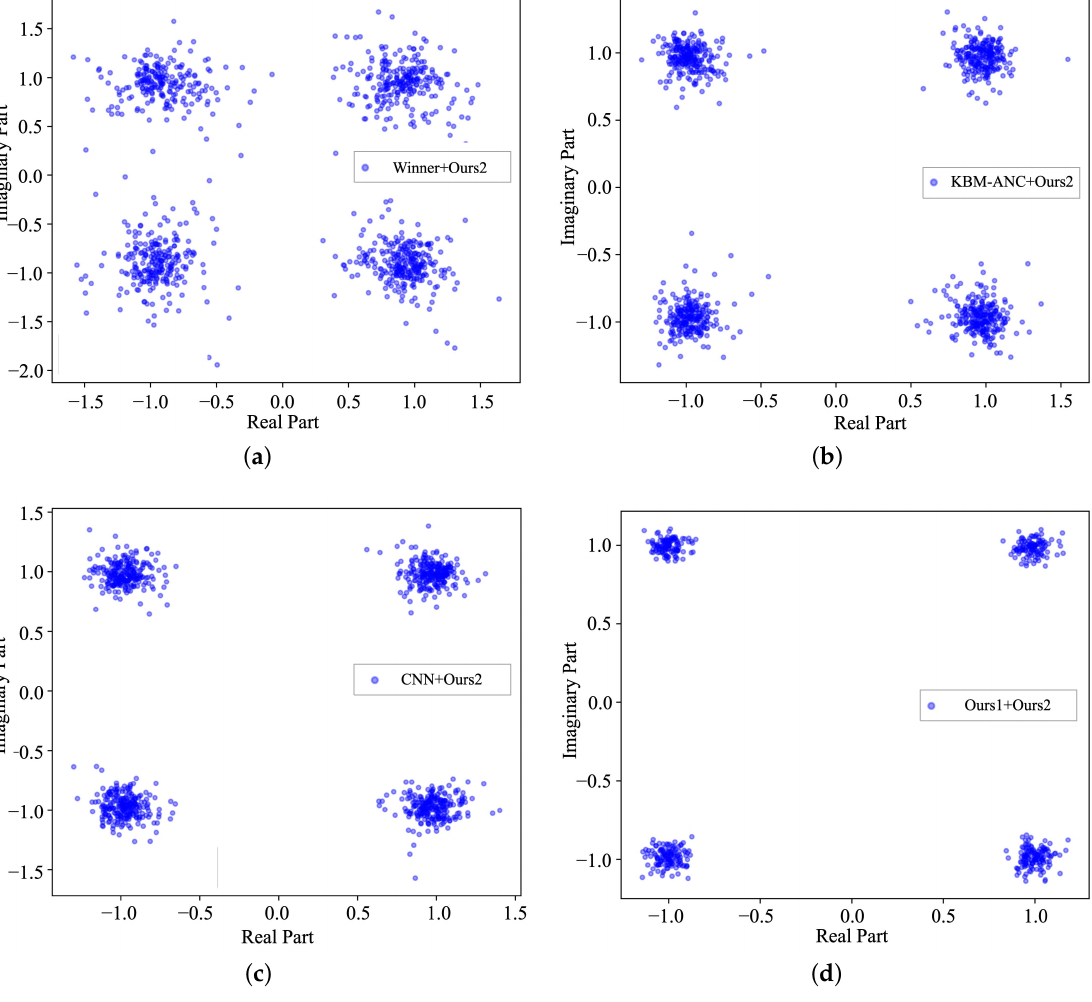
Figure 23. The comparison of constellation diagrams of different methods: ( a ) the constellation diagrams for “Wiener+Ours2”; ( b ) the constellation diagrams for “KBM-ANC+Ours2”; ( c ) the constellation diagrams for “CNN+Ours2”; ( d ) the constellation diagrams for the proposed joint processing